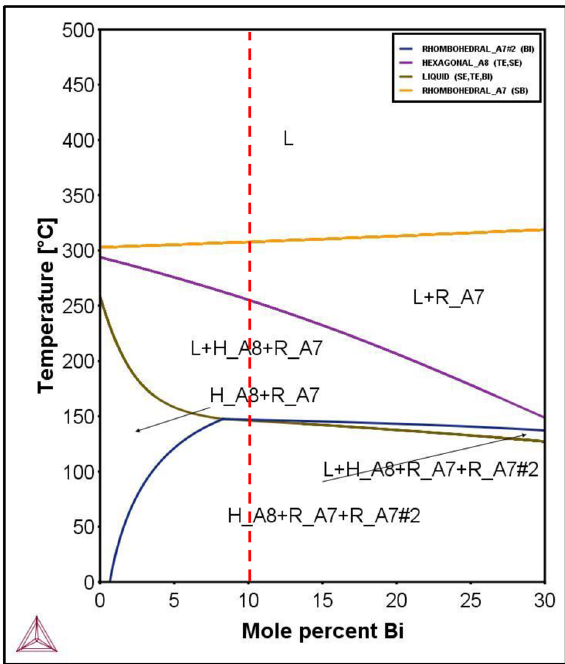
Figure 2. The pseudo-binary phase diagram of the BSTS alloy.